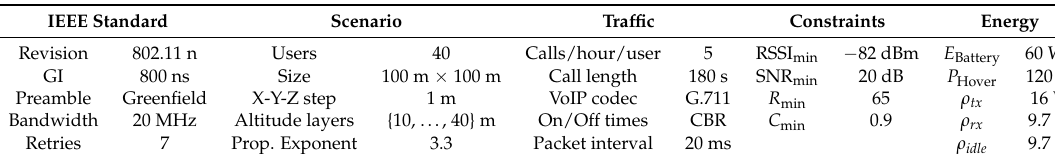
Table 3. Example solution input parameters.